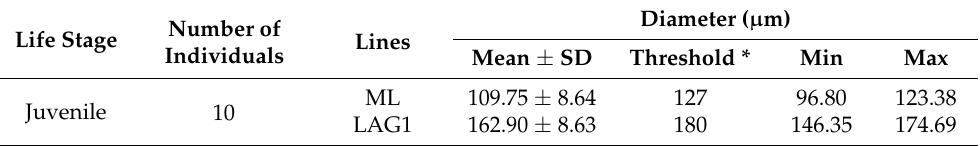
Table 1. The diameter values of ML and LAG1 in laboratory-reared juvenile K. borealis .